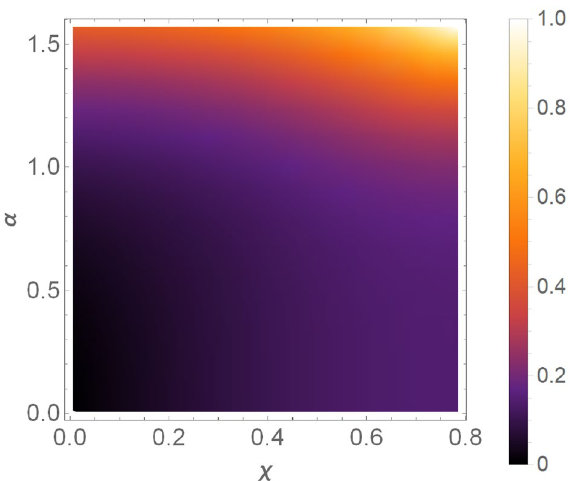
Figure 2. Success probability of obtaining arbitrary state from a two-parameter subclass of the GHZ class in π 0 , the success probability vanishes, indicating α ψ GHZ (χ , π , α , α , α) Eq. (22) of the form . For χ 4 and = → | � that these states cannot be effectively obtained via SLOCC